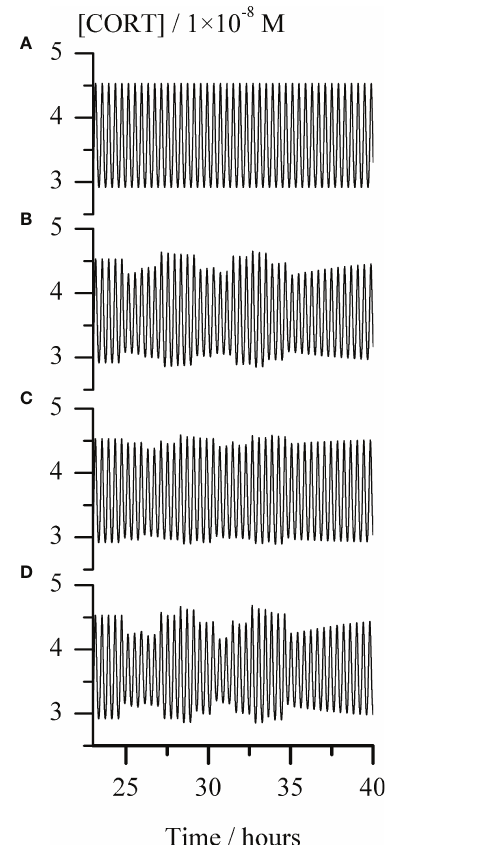
DC FIGURE 5 Temporal evolution of cortisol concentration ([CORT]) for repeating single-pulse perturbations with each stimulator of ACTH release alone and in combination, for the arbitrarily chosen time interval between around 23 and 40 hours. Graph (A) - the unperturbed extended model of HPA axis; Graphs (B – D) responses of the HPA axis to repeating pulse perturbations with: (B) CRH (C) AVP and (D) conjoint CRH and AVP. The perturbation intensities of each stimulator of ACTH secretion were the same in all corresponding cases, [CRH] = 2.5 × 10 − 9 M and AVP [AVP] = 50.0 × 10 − 9 M. In all Graphs (B – D) , the fi rst pulse perturbations were applied in the maximum-to-minimum in fl ection point of a selected ultradian cortisol oscillation starting from the one at 1490 th minute (circa 24.8 h) and repeated every 66 minutes, giving a total of 10 pulses perturbations. In all cases presented in Graphs (A – D) , rate constants (k 2.1 and k 2.2 ) = (1.647 and 4.575) × 10 − 8 mol dm − 3 min − 1 and k 5.3 = 1.098 × 10 10 mol − 1 dm 3 min − 1 , while all other rate constants had values as given in Table dynamics is much more complex since dynamic state depends zero. This corresponds to the initial model (54). Under these strongly on values of both k 5.3 and k 2.1 . Namely, for low values of conditions, amplitudes do not depend on k 5.3 and hence only one value of amplitude is given for each k 2.1 value. In this case, k 2.1 , only stable steady states were found as in the fi rst case for lower values of k 2.1 (such as for k 2.1 < 1.6470 × 10 − 8 mol dm − 3 (Figure 2, ● ). With slightly increased k 2.1 (such as for k 2.1 = min − 1 ) stable steady states were observed fi rst. With k 2.1 oscillatory dynamic states were found in region of low k 5.3 values increase, HPA system passes to another stable steady state transiting through oscillatory region con fi ned between two but stable steady states in the region of high k 5.3 values. With supercritical AH bifurcation points. It was also observed that further increase of k 2.1 , only oscillatory dynamic states are the amplitudes reach their maximum at a certain k 2.1 value present for all k 5.3 values. This refers to four values of k 2.1 in within oscillatory region, which gradually decreases with Table 2, which correspond to four adjacent points denoted by ◼ approach to the AH points. In the second case, where k 2.2 is in Figure 2. Moreover, the values of amplitude were found to be in fl uenced by k 5.3 . At modestly low values of k 2.1 , oscillations